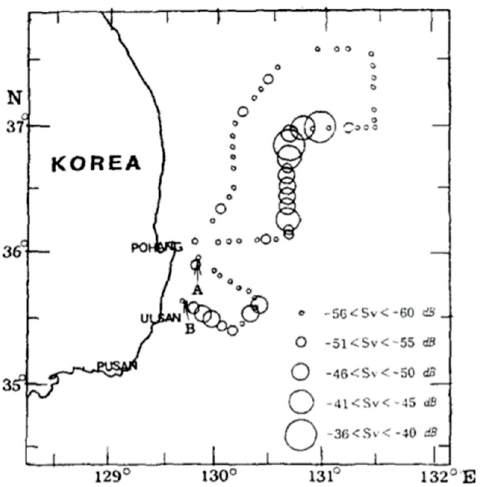
Figure 14. Hydroacoustic investigations on the distribution characteristics of the anchovy at the south region of East Sea [17].